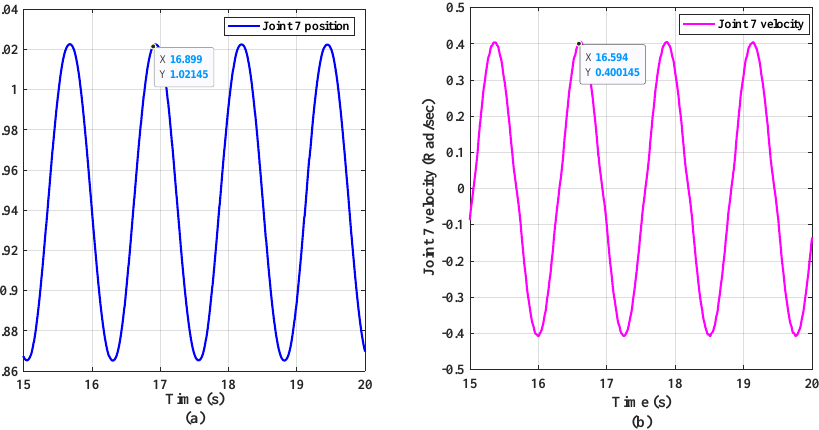
Figure 8. The angular and angular velocity motion of end joints. ( a ) angular changes; ( b ) angular velocity